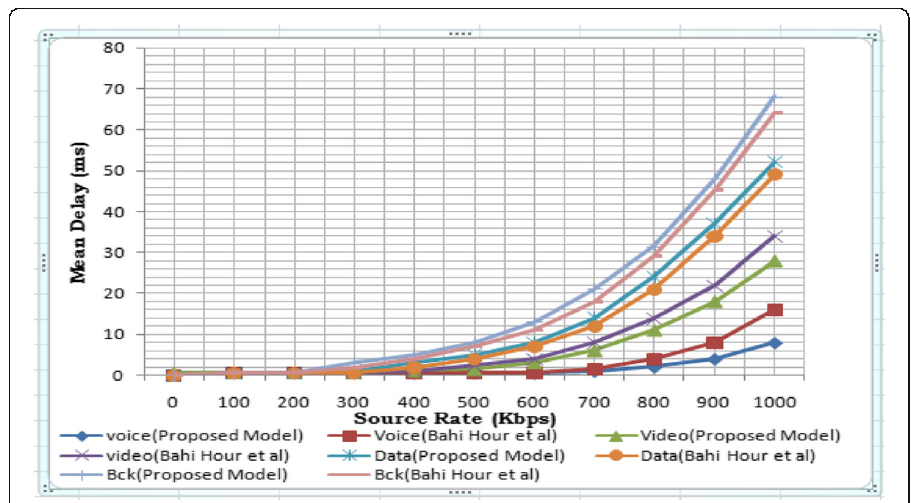
Fig. 11 Impact of network load on delay for model and validation